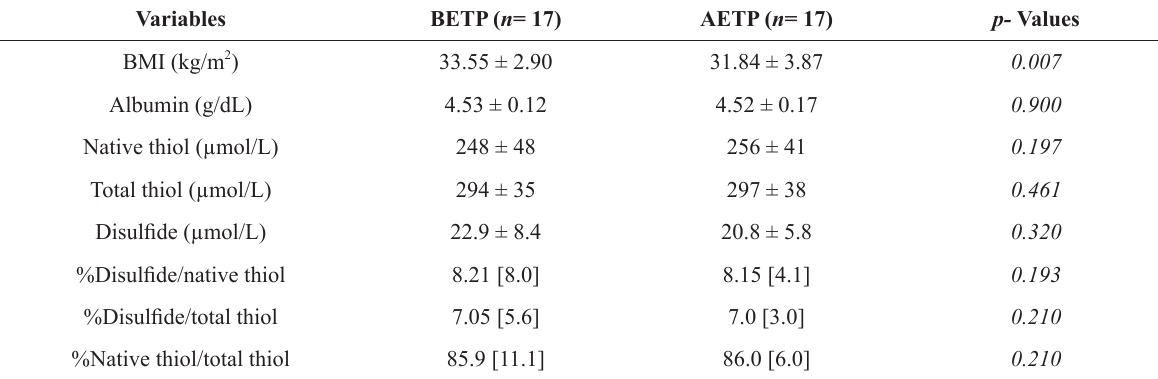
The comparisons of albumin and TDH parameters in the obese group prior to and after the completion of the exercise training program.